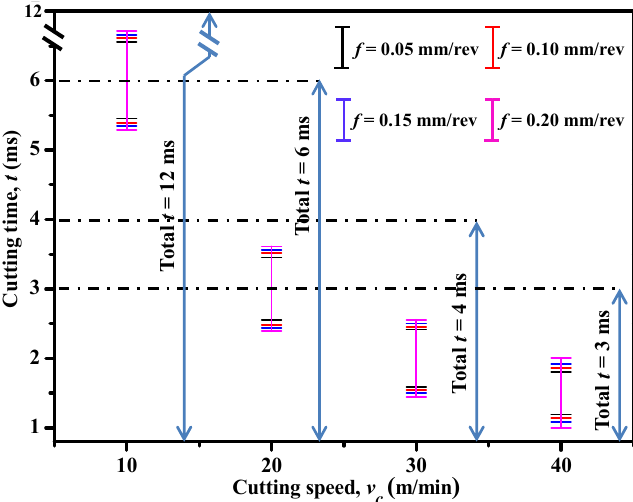
Figure 14. Effects of cutting speed ( v c ) and feed rate ( f ) on cutting duration of AIZ (Note: “ I ” indicates the cutting duration of AIZ) ( θ = 0°).